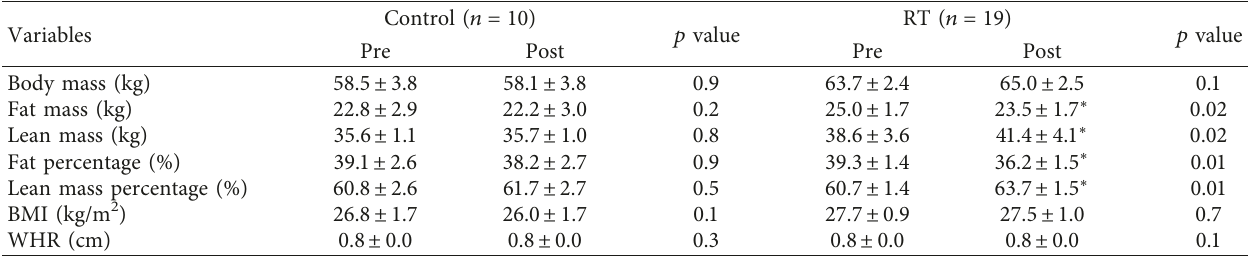
Table 2: Anthropometric characteristics, body composition and lipid profile, in RTand Control groups at Pre and Post (8 weeks) moments. Variables